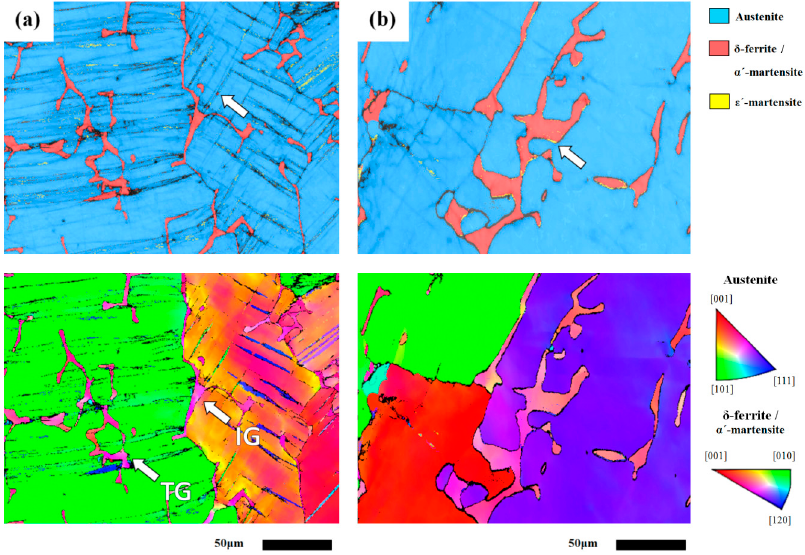
Figure 4. The EBSD image (top) and the corresponding IPF (bottom) of the ( a ) 308L-CR and ( b ) 308L-CRS specimens.